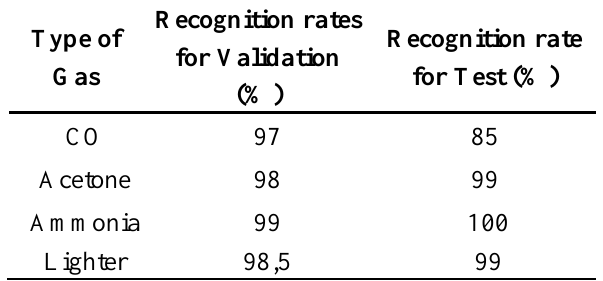
Table 2. The recognition results for testing of neural